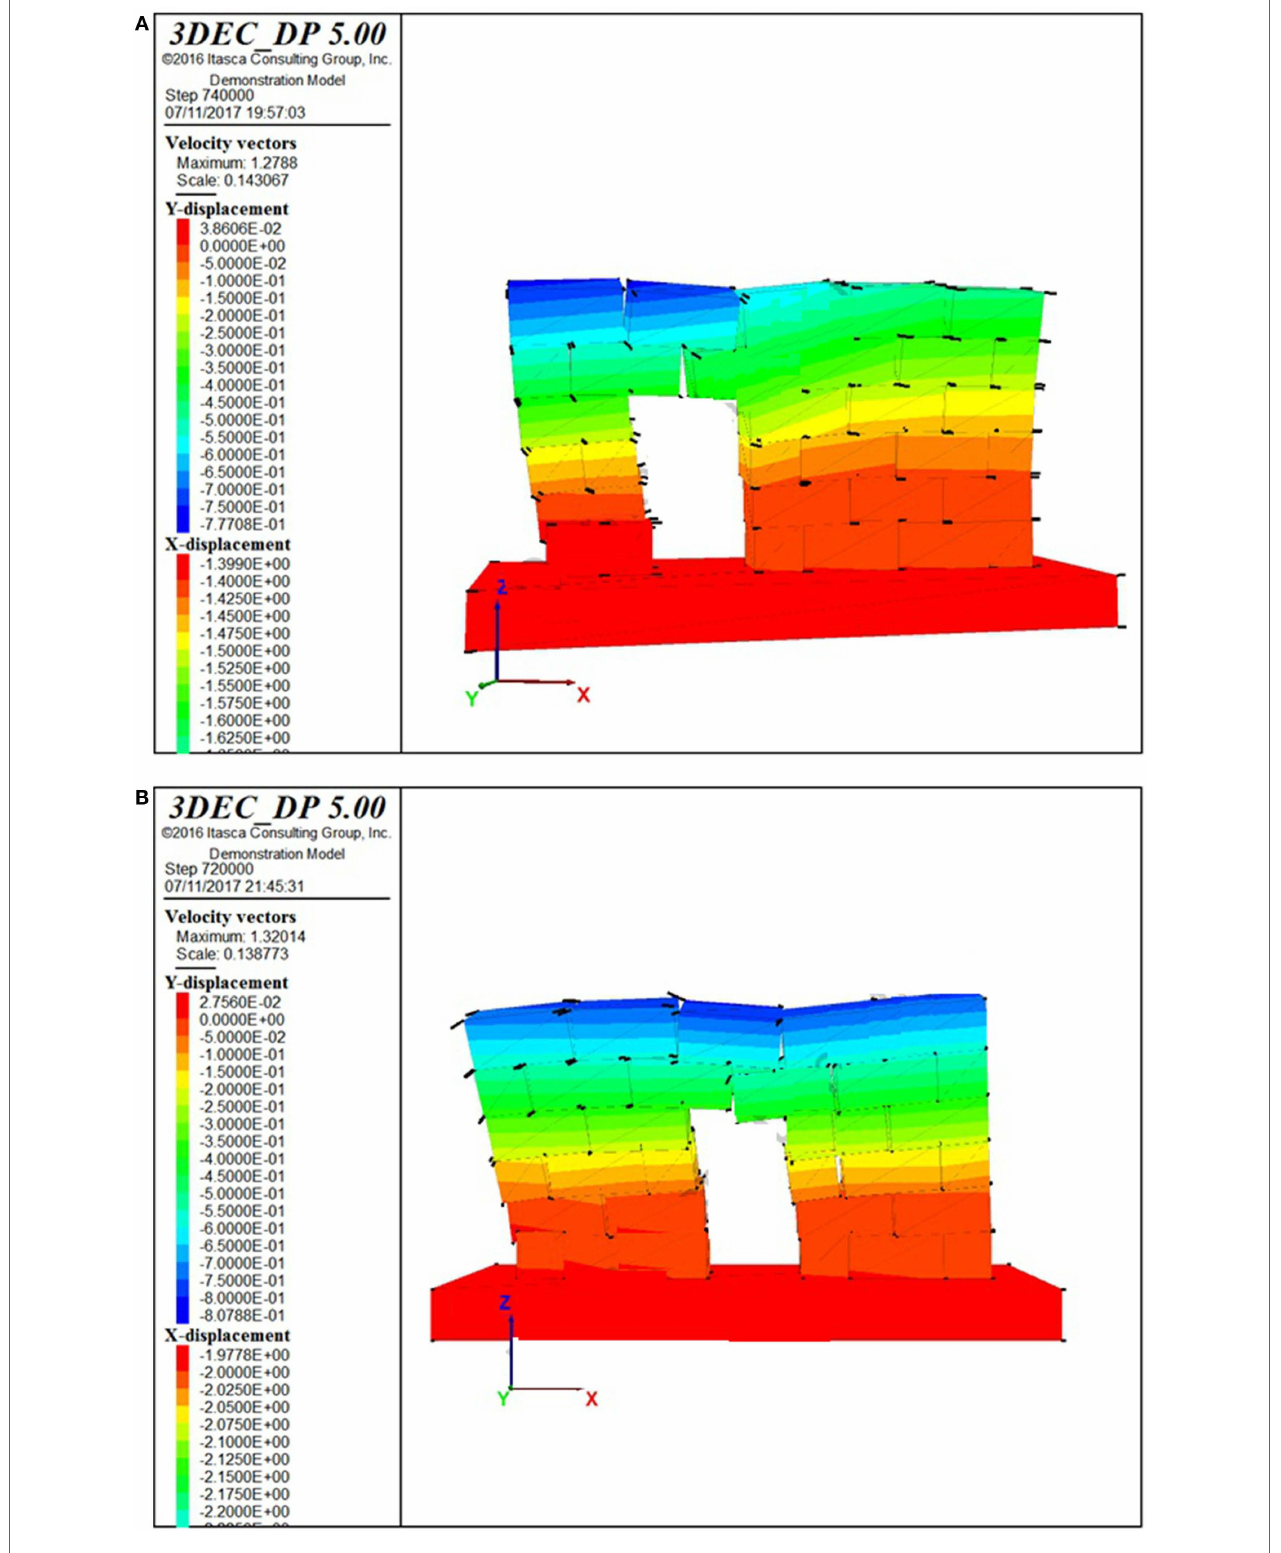
FIGURE 13 | Collapse mechanism for model I4 with (A) A = 1m (0.20g) and (B) A = 2m (0.10g).